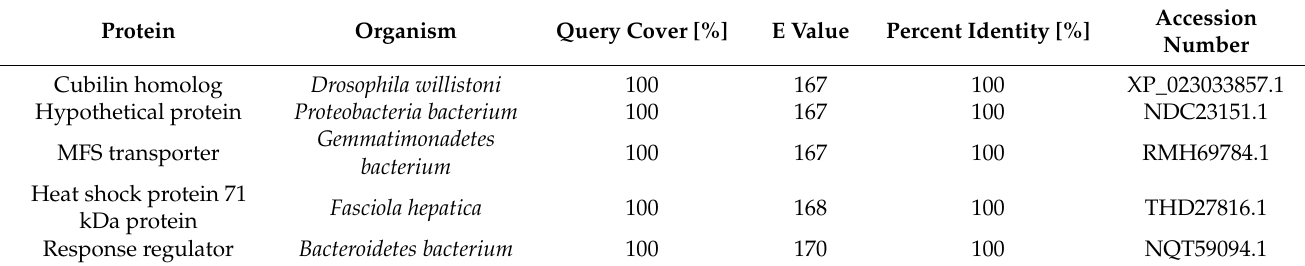
Table 4. Proteins containing fragments homological to the Symbodinium sp. RbcL insert in the 425 position. Protein